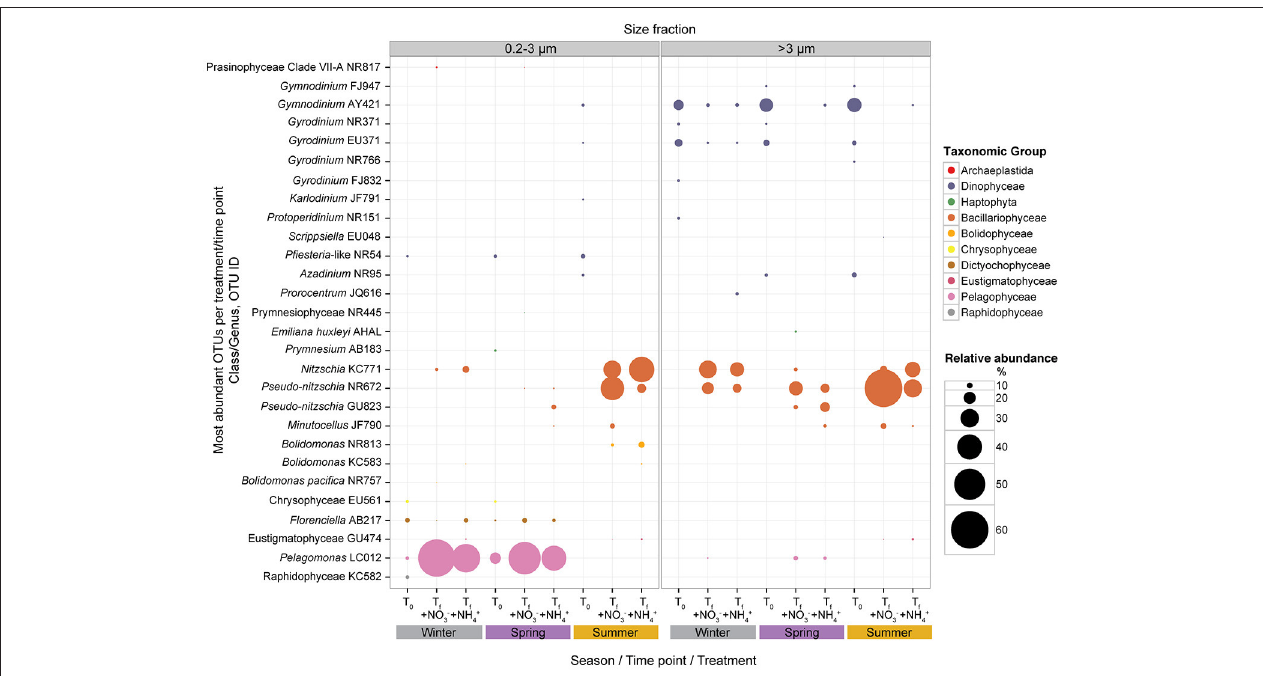
FIGURE 5 | Mean relative abundances (%) of the most abundant pico- and > 3 µ m phytoplankton at initial (T 0 ) time points and final (T f ) time points for + NO − 3 and + NH + 4 treatments; experiments binned by season (winter, spring, and summer). Mean relative abundances of phytoplankton taxa depicted using different colors and bubble sizes (size reflects relative abundance). Detailed information on the OTUs listed is listed in Supplementary Table